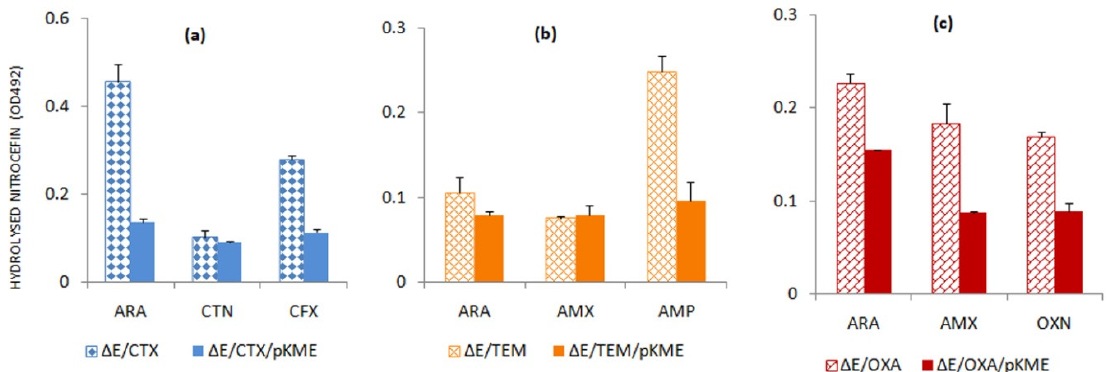
Figure 3. Differential induction by arabinose and characteristic substrates of the